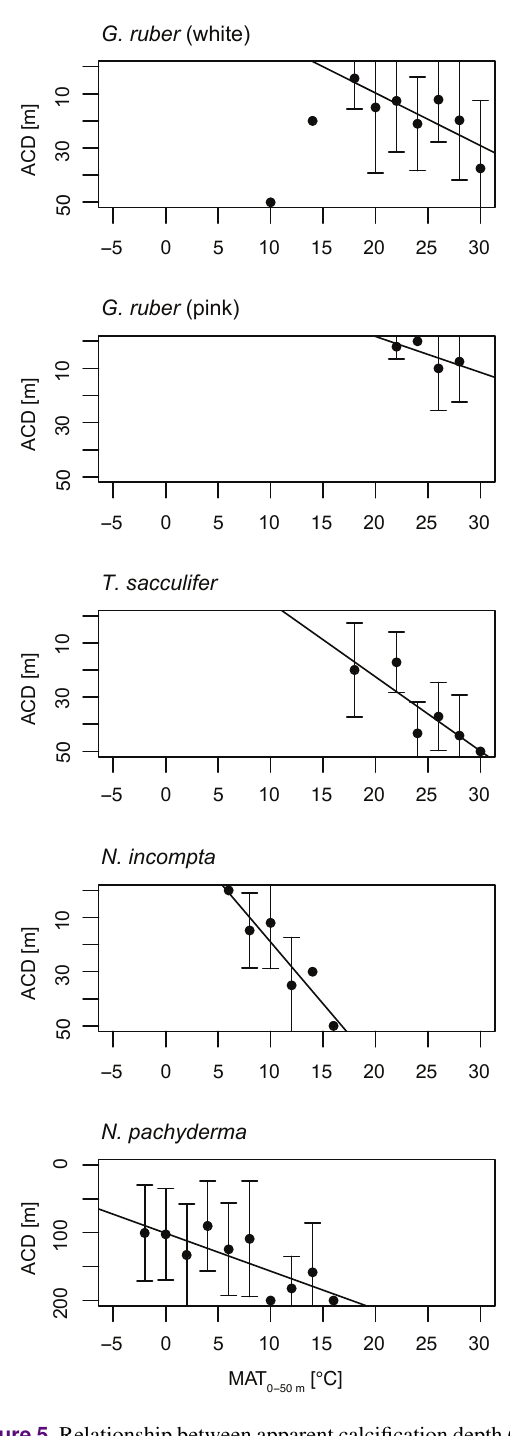
Figure 5. Relationship between apparent calcification depth (ACD) and temperature. Data are summarised in 2 ◦ C bins and error bars represent standard deviations within each bin. The data points at the cold temperature end of G. ruber (white) are excluded since these are more likely to reflect outliers or advected